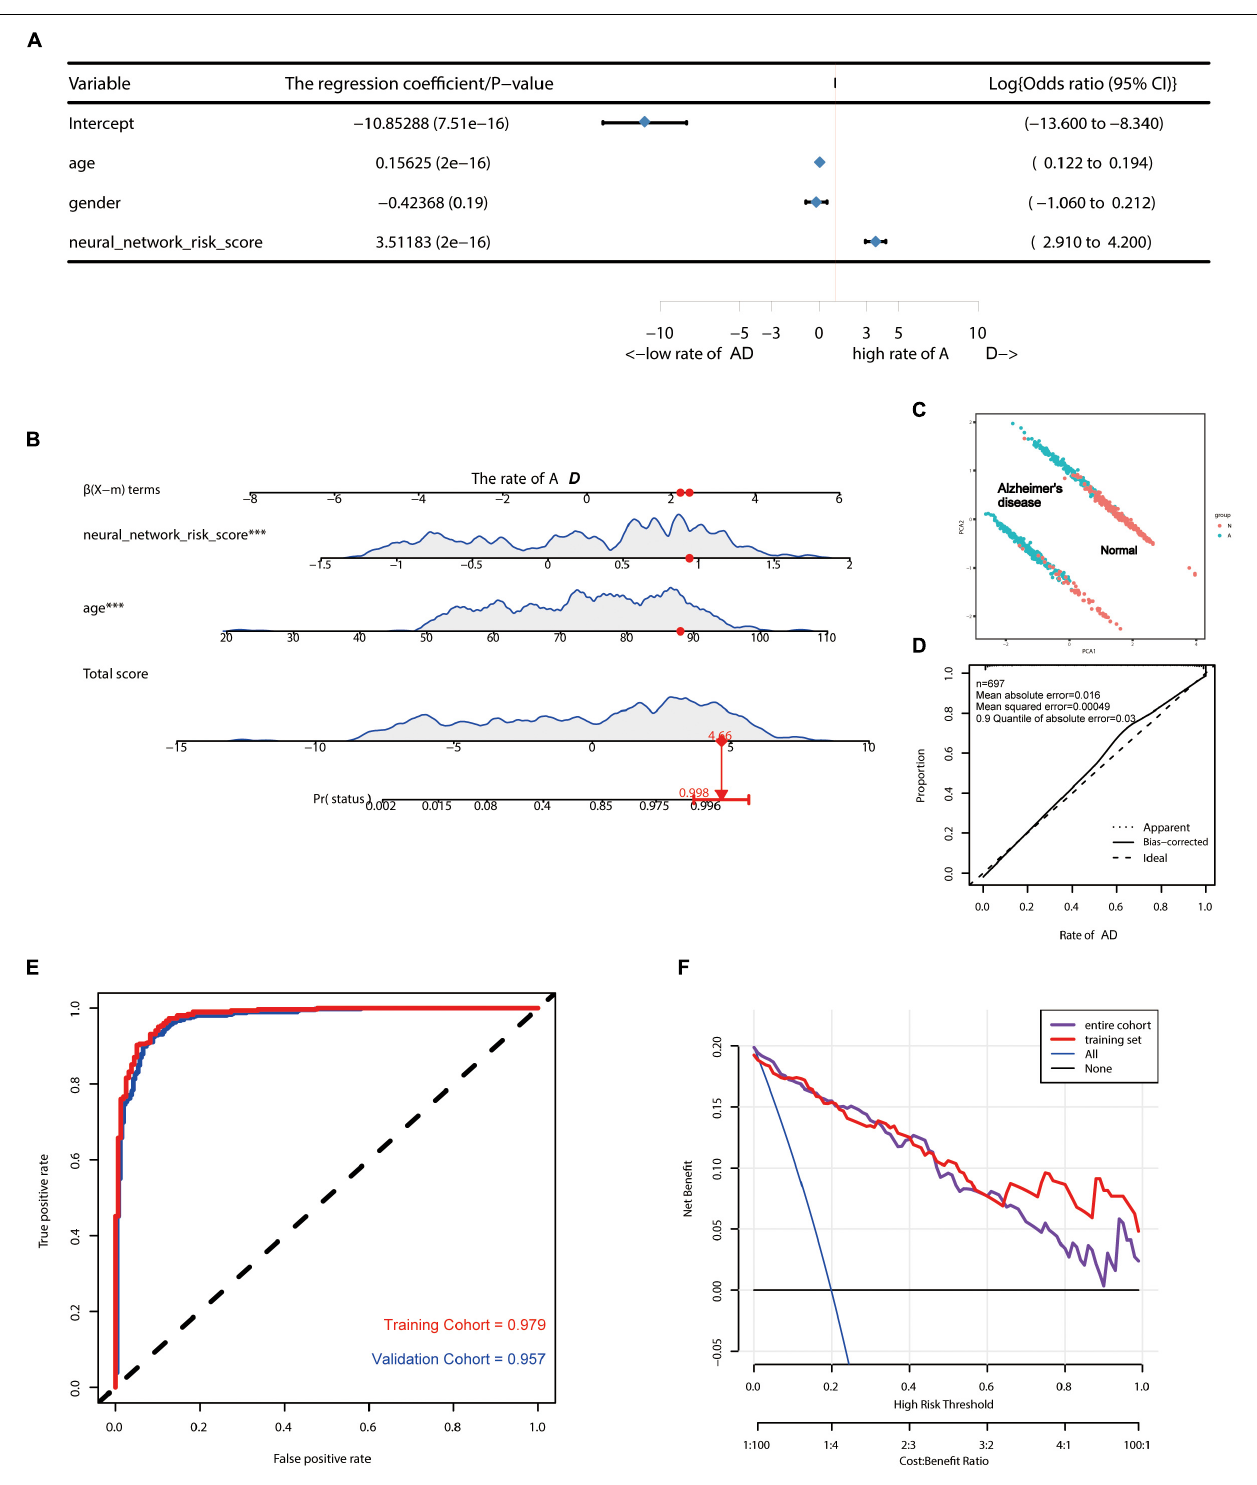
FIGURE 3 | Construction of AD risk nomogram model based on neural network model. (A) A forest plot for multifactor logistical analysis based on age, gender, and neural network risk score. (B) A nomogram prediction model was constructed using neural network risk score and age. (C) PCA suggests that the model is better able to distinguish AD from normal patients. (D) The calibration curve of this nomogram prediction model after including a sample of 697 cases. (E) ROC curves of the AD risk nomogram prediction model constructed based on the neural network model for the training group (AUC = 0.979) and the test group (AUC = 0.957). (F) DCA curves of this nomogram prediction